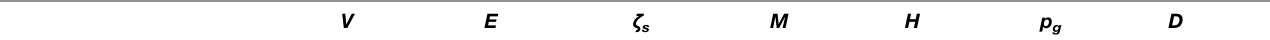
Table 2. Network-Based Methodology